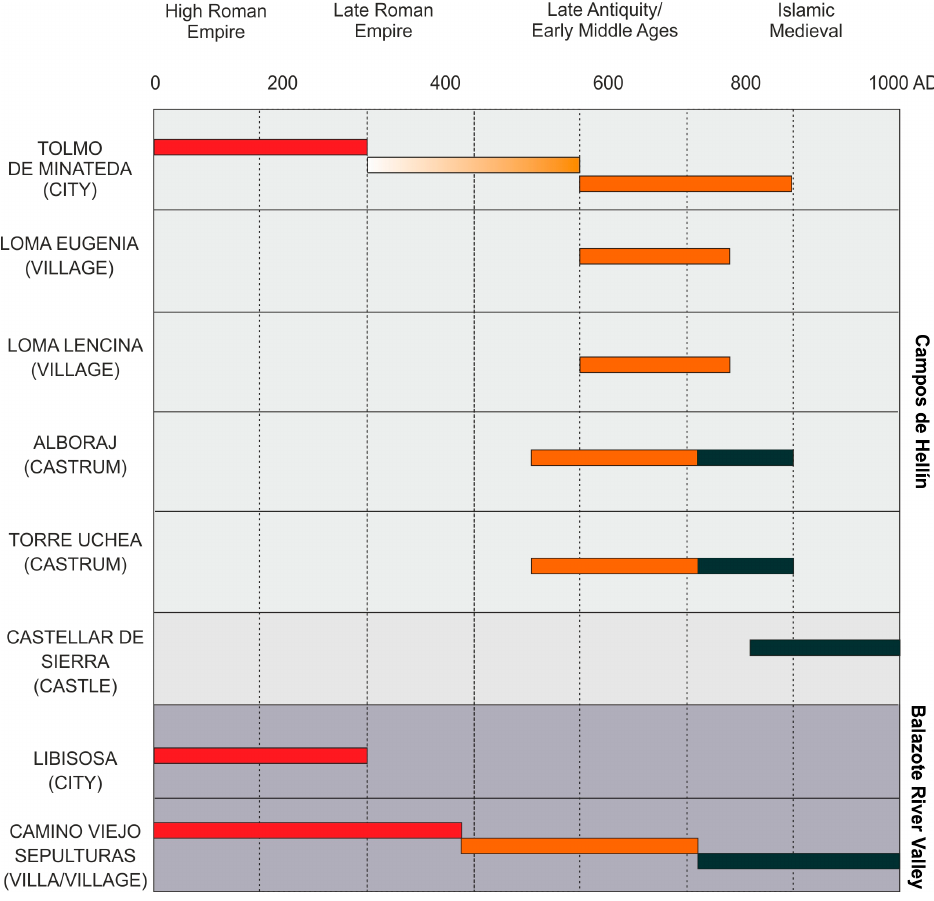
Figure 12. A diagram showing the chronology of the occupation of the settlements in both study areas, based on the diagnostic ceramic fragments that were